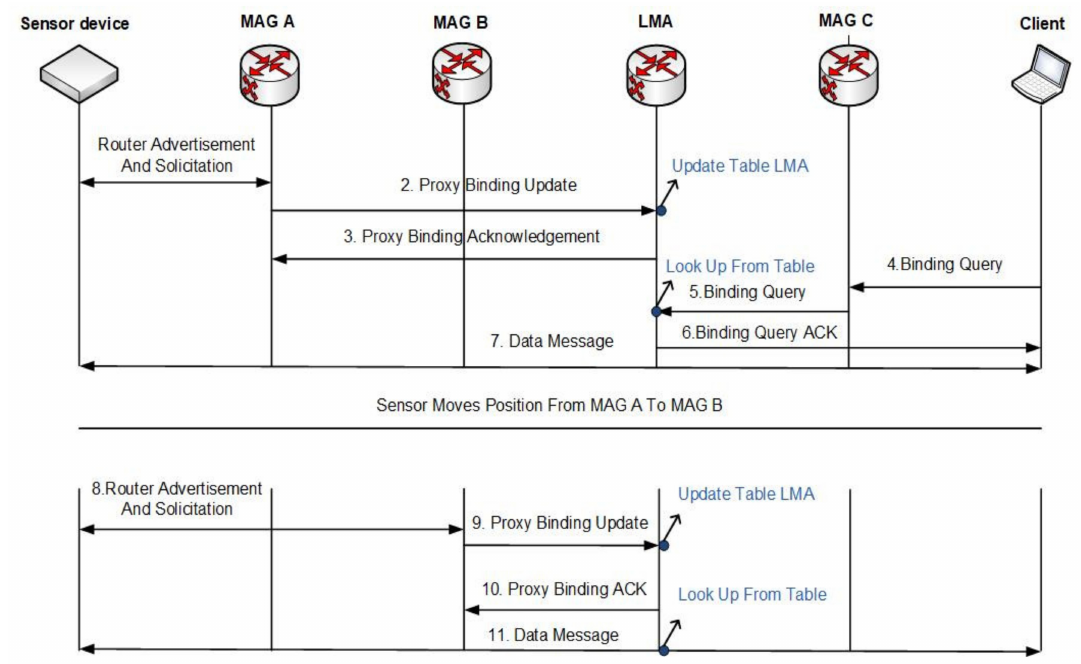
Figure 1. Constrained Application Protocol (CoAP) for Proxy Mobile IPv6